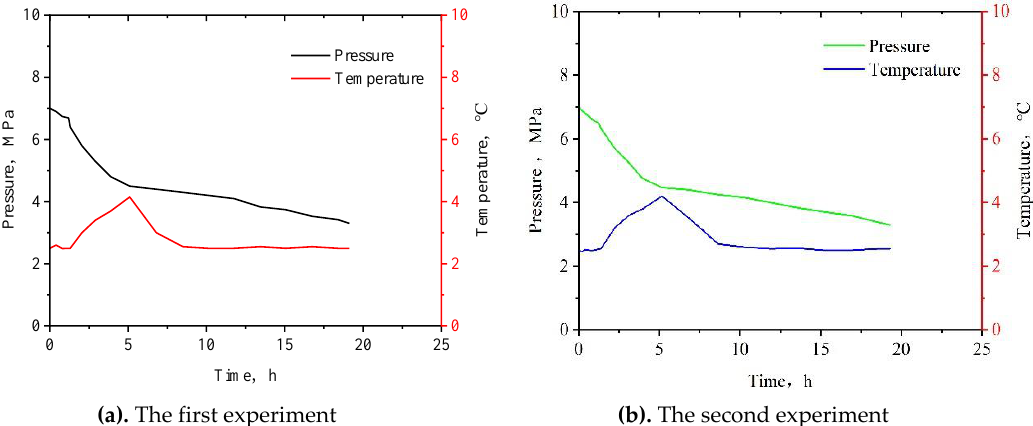
Figure 13. Preparation process of natural gas hydrate by three-in-one method. The yellow dotted line indicates the hydrate boundary. ( a ) In the first panel, The white flocculent is hydrate. The area of darker color in contact with hydrate is the prepared water. The white bright spot is the light of the fill light lamp. ( b ) In the second panel, The white flocculent is hydrate. The area of darker color in contact with hydrate is the prepared water. The white bright spot is the light of the fill light lamp. ( c ) In the third panel, The white flocculent is hydrate. The area of darker color in contact with hydrate is the prepared water. The white bright spot is the light of the fill light lamp. ( d ) In the fourth panel, The white flocculent is hydrate. The white bright spot is the light of the fill light lamp.